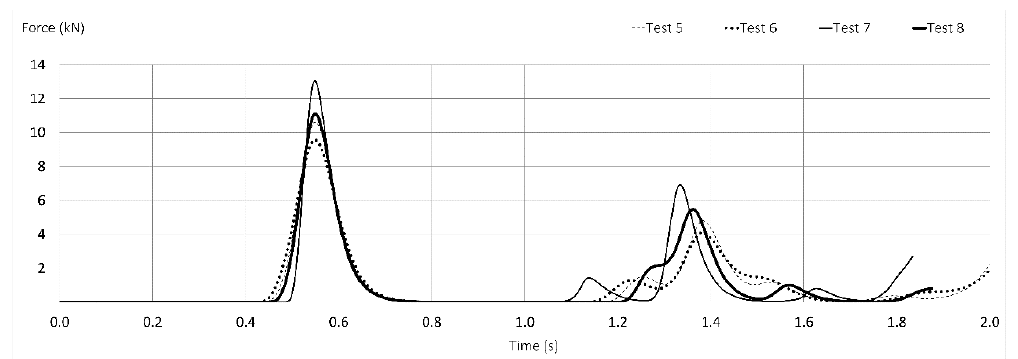
Figure 7. Time-force curves of Tests 5 to 8 (commercialized lanyards) with FF = 1.